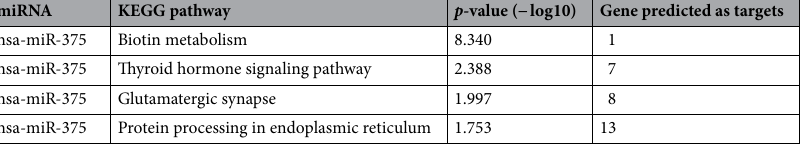
Table 5. Significant KEGG pathways potentially influenced by up-regulated miR-375 in the aqueous humor of normal tension glaucoma patients. KEGG Kyoto encyclopedia of genes and